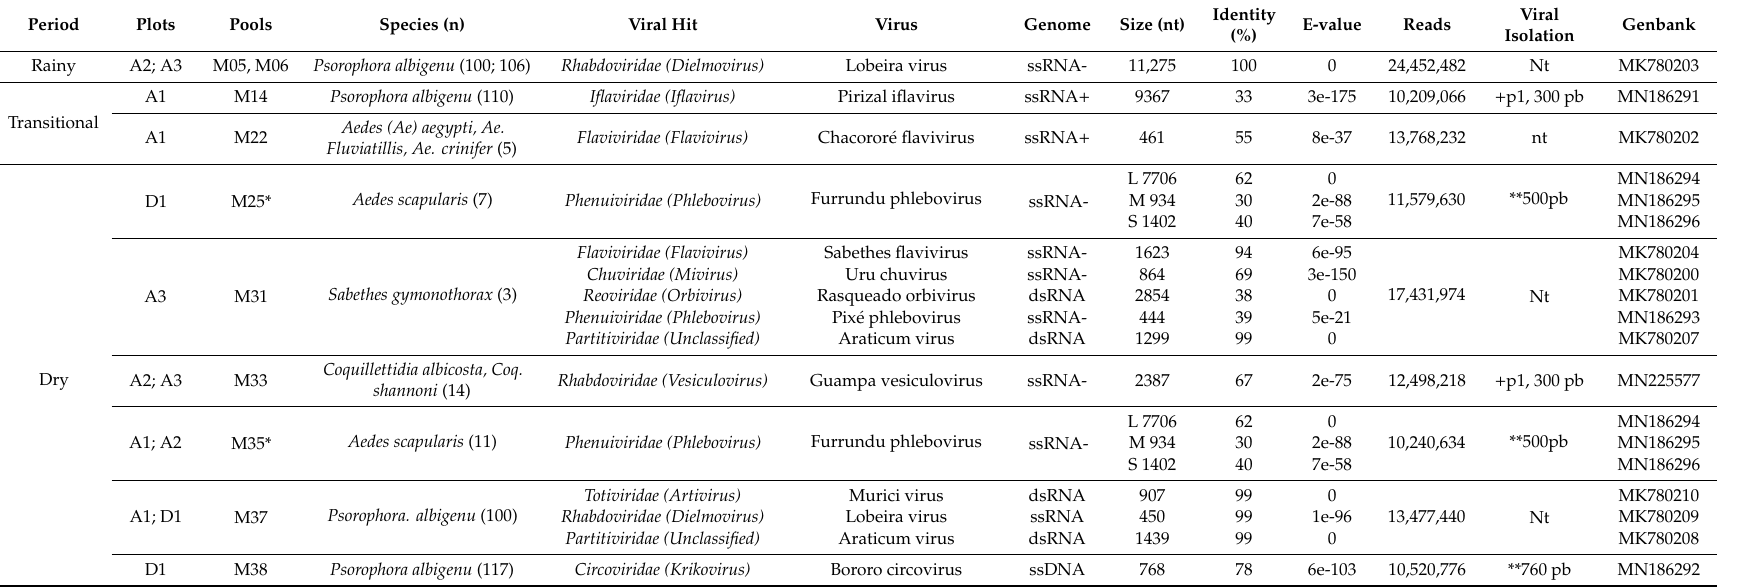
Table 1. Data obtained from culicinae pools captured in di ff erent climate periods at High Pantanal, Central-Western Brazil and subjected to high throughput sequencing. Period Plots Pools Species